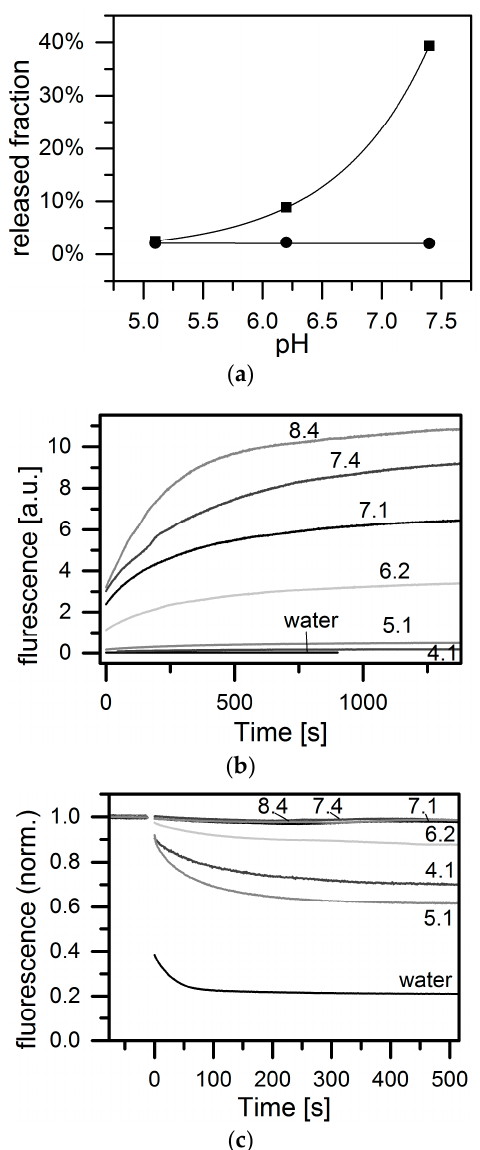
Figure 3. ( a ) Fraction of fluorescein released from prefilled MOF-NPs after 90 min in buffer (HBG) at different pH, determined by absorption measurements of supernatant containing free fluorescein. While MIL-101(Cr) (circles) shows almost no (<3%) release of fluorescein at any pH tested, for MIL-100(Fe) (squares) we observed a significant increase in release with rising pH (exponential fit to guide the eye); ( b ) Fluorescence quenching over the time course of release. MIL-100(Fe) nanoparticles filled with fluorescein were suspended in HBG buffered at different pHs. In water there is no increase in fluorescence intensity over time, indicating that there is no release; ( c ) Fluorescence quenching in the time course of loading. Fluorescein solution in HBG buffer at different pH and in water before and after addition of MIL-100(Fe) nanoparticles. In water the loading is the fastest and most efficient. In HBG at pH 4.1 to 6.2 it is slower and less efficient while at pH 7.1 to 8.4 no loading is observed at all.